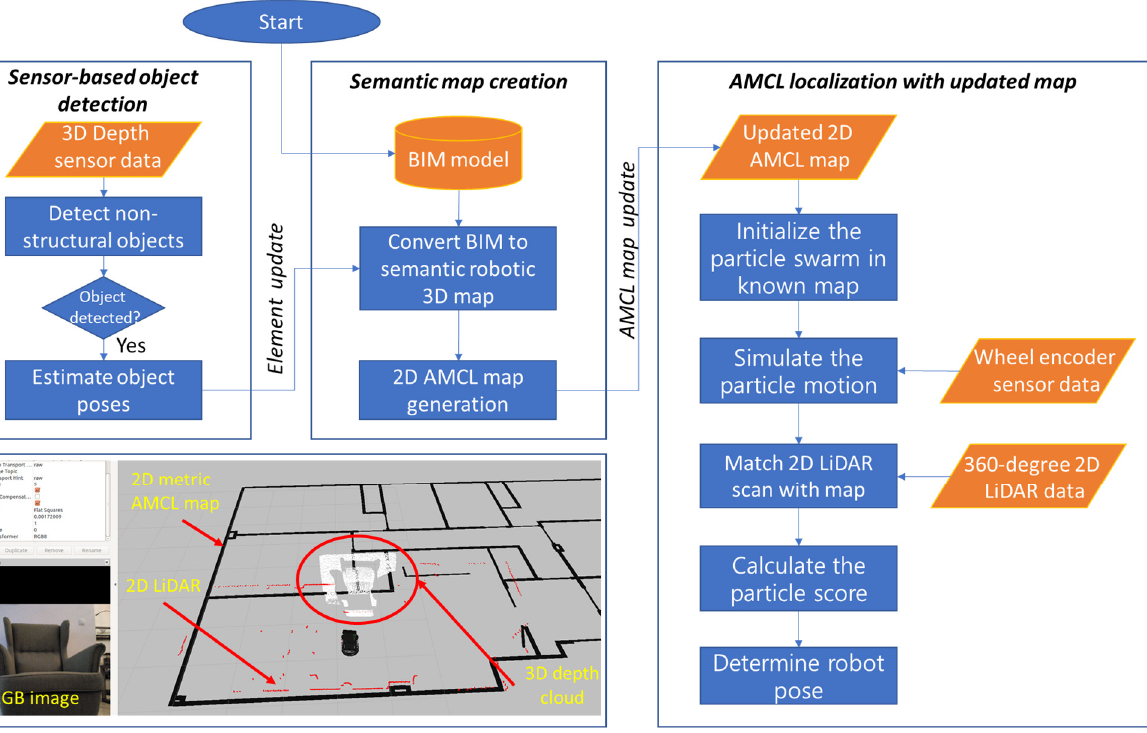
Appl. Sci. 2023 , 13 , x FOR PEER REVIEW